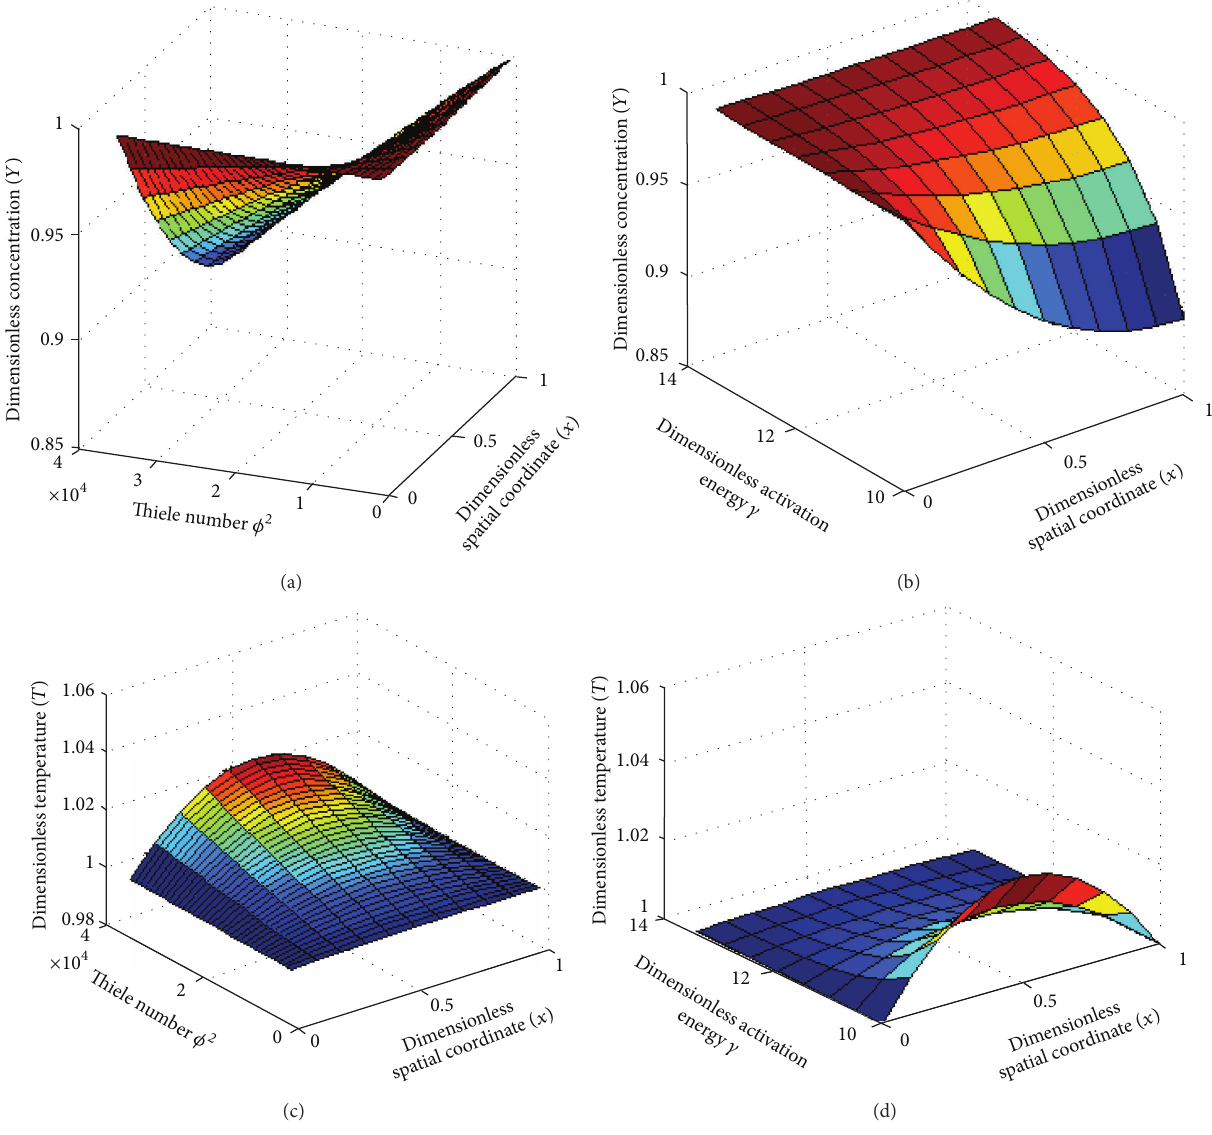
Figure 5: (a) The normalized three-dimensional concentration of gas reactant Y versus dimensionless spatial coordinate 𝑥 and Thiele number 𝜙 2 , (b) the normalized three-dimensional concentration of gas reactant Y versus dimensionless spatial coordinate 𝑥 and dimensionless activation energy 𝛾 , (c) the normalized three-dimensional temperature T versus dimensionless spatial coordinate 𝑥 and Thiele number 𝜙 2 , and (d) the normalized three-dimensional temperature T versus dimensionless spatial coordinate 𝑥 and dimensionless activation energy 𝛾